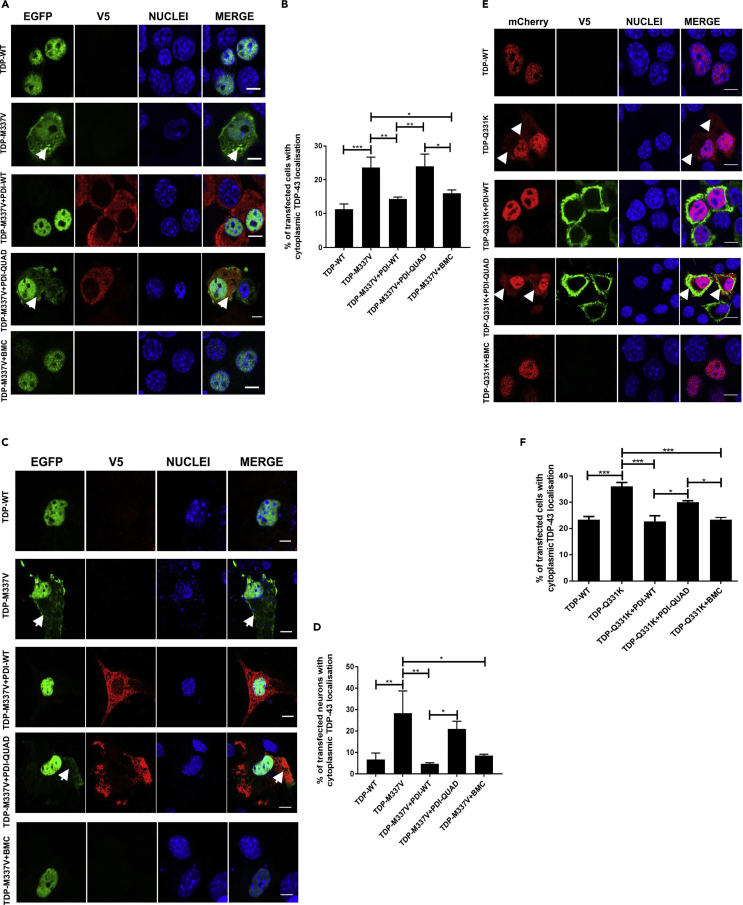
The Oxidoreductase Activity of PDI Is Protective against TDP-43 Mislocalization to the Cytoplasm(A) Neuro-2a cells expressing EGFP-tagged TDP-WT (row 1), TDP-M337V with empty vector (row 2), co-expressing PDI-WT or PDI-QUAD, or treated with BMC (rows 3, 4, 5), arrows repesent mislocalised TDP-43.(B) Expression of PDI-WT (∗∗p < 0.01) or administration of BMC (∗p < 0.05) to mutant TDP-M337V-expressing cells significantly reduced the proportion of cells displaying cytoplasmic TDP-43. A significant difference in cells expressing cytoplasmic TDP-43 was observed between PDI-WT and PDI-QUAD (∗∗p < 0.01), and between PDI-QUAD and BMC (∗p < 0.05).(C) Primary neurons expressing TDP-WT (row 1), TDP-M337V with empty vector (row 2), co-expressing PDI-WT or PDI-QUAD, or treated with BMC (rows 3, 4, 5), arrows repesent mislocalised TDP-43.(D) Over-expression of PDI-WT (∗∗p < 0.01) or BMC treatment (∗p < 0.05) in mutant TDP-M337V-expressing cells significantly reduced the proportion of cells displaying cytoplasmic TDP-43. There was also a significant difference between TDP-M337V cells co-expressing PDI-WT and those co-expressing PDI-QUAD (∗p < 0.05).(E) Neuro-2a cells expressing mCherry-tagged TDP-WT (row 1), TDP-Q331K (row 2), or co-expressing PDI-WT or PDI-QUAD, or treated with BMC (rows 3, 4, 5), arrows repesent mislocalised TDP-43(F) Expression of PDI-WT or treatment with BMC (∗∗∗p < 0.001) in mutant TDP-Q331K-expressing cells significantly reduced the proportion of cells displaying cytoplasmic TDP-43, compared with cells expressing empty vector only. A significant difference was observed between PDI-WT and PDI-QUAD, and between PDI-QUAD and BMC treated cells (∗p < 0.05).Scale bars: 10 μm in (A) and (E), 5 μm in (C).